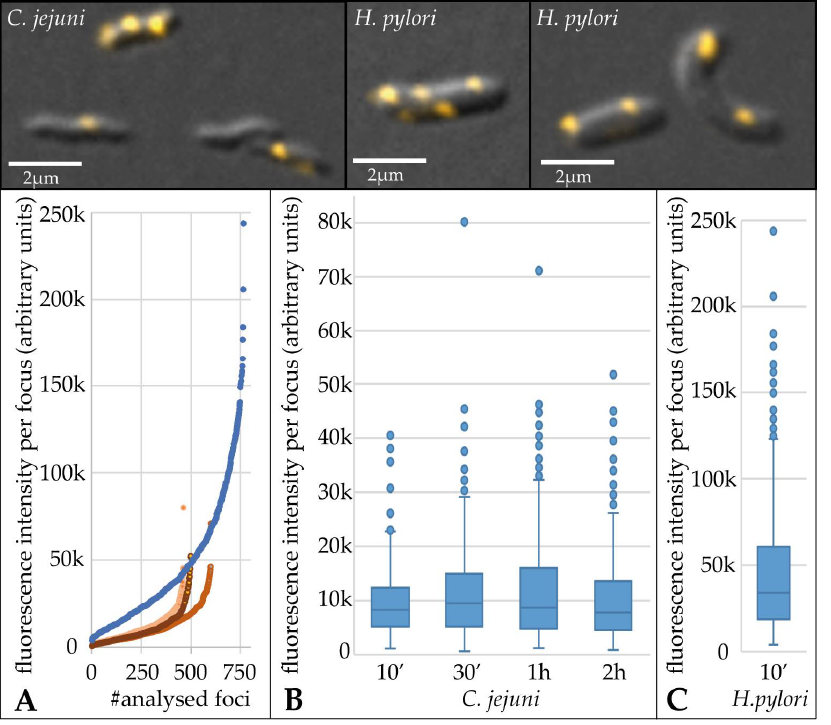
Figure 3. The median amount of DNA within single foci of C. jejuni was constant over time and ~4-fold less than in H. pylori . C. jejuni 81–176 and H. pylori J99 were incubated with the same batch of fluorescent genomic C. jejuni DNA labelled with Cy3. Uptake was followed in time for C. jejuni and compared to 10 min uptake in H. pylori . ( A ) Analysis of DNA foci in C. jejuni (red; light to dark corresponds to incubation times) and in H. pylori (blue), sorted according to fluorescence intensity. ( B ) ( C. jejuni ) and ( C ) ( H. pylori ) distribution of fluorescence intensities as boxplots; the boxplot length corresponds to the interquartile range (IQR; 50%) of data, the horizontal bar indicates the median value; whiskers represent 1.5 × IQR or the maximum/minimum value of the dataset; dots, outliers. Upper panel, merged DIC and Cy3-channel example images of C. jejuni and H. pylori cells after import of DNA. Note that Cy3 exposure times were 25 ms for H. pylori and 100 ms for C. jejuni . Scale bar of 2 µm. One representative experiment (out of three) is shown.